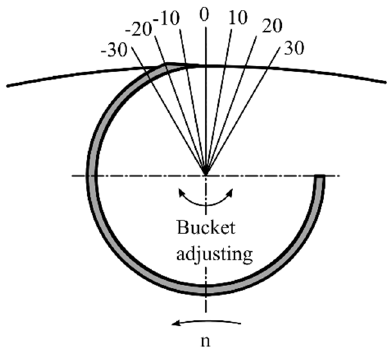
Fig. 5. Labelling of the bucket adjusting .